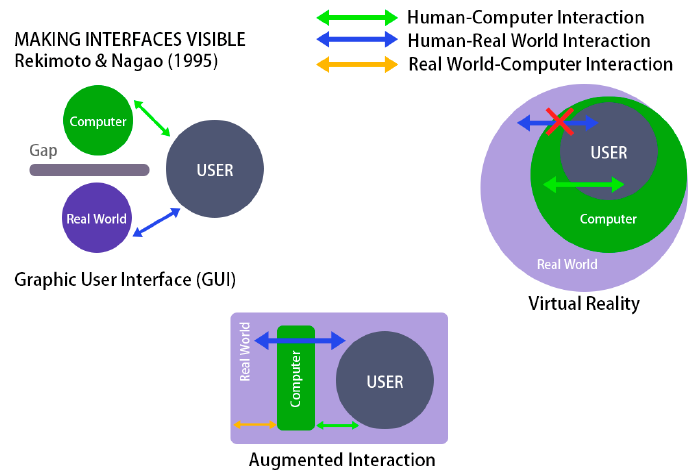
Figure 2. An approach of styles of interaction and interfaces, by Rekimoto and Nagao in the 90s [92]. They propose, in an early phase of the theoretical approach to interaction with virtual reality, a conceptual approach comprising the user, the computer (defined not as interface but as digital or artificial information) and the real world. Even though approaches in interfaces for VR and immersive environments have evolved, the conceptual models developed later include, as basic components, the relationship between user, information and environment, being useful for developing virtual reality